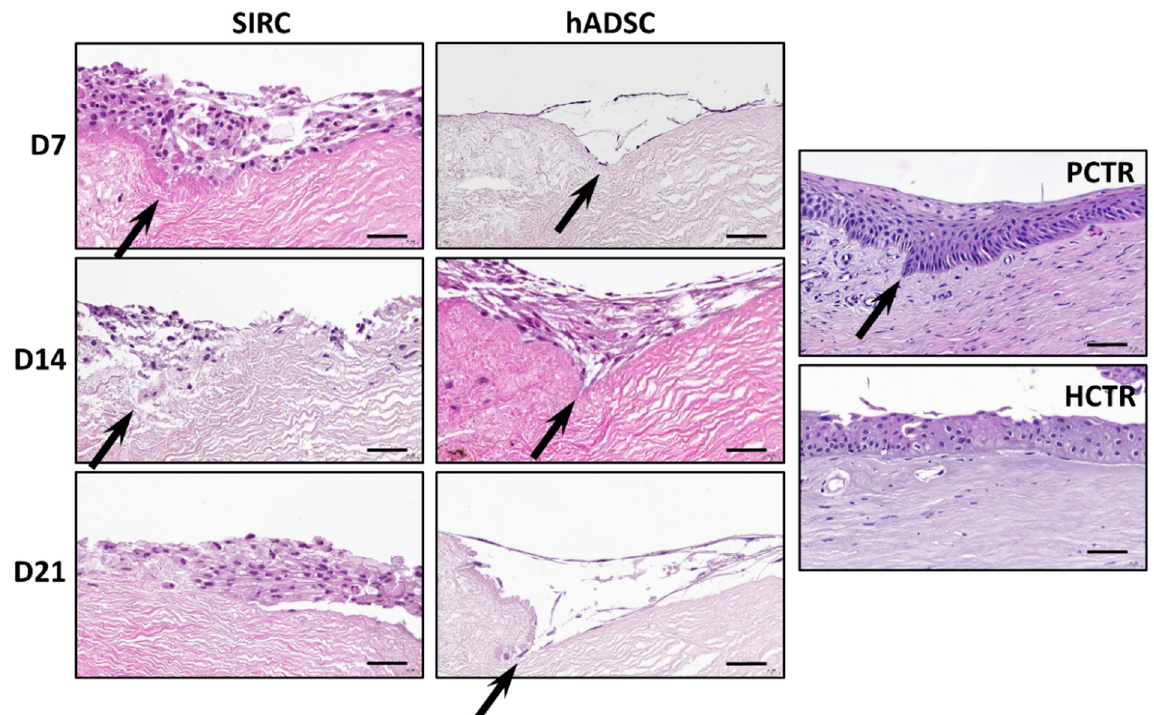
Figure 5. Histological analysis of native controls and RLs recellularized with SIRC epithelial cells and hADSCs, at days 7 (D7), 14 (D14), and 21 (D21) of follow ‐ up using hematoxylin ‐ eosin staining (HE). PCTR: Native porcine limbus used as control. HCTR: Native human limbus used as control. Pocket ‐ like structures found in some of the images have been highlighted with arrows. Scale bars: 50 μ m.